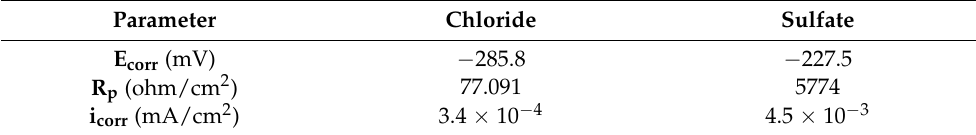
Figure 3. Potentiodynamic polarization curves of NiW coatings in neutral 3.5 wt% NaCl solution (areas on X-axis are visible and not real). Table 1. Corrosion parameters for NiW coatings (areas are visible and not real).